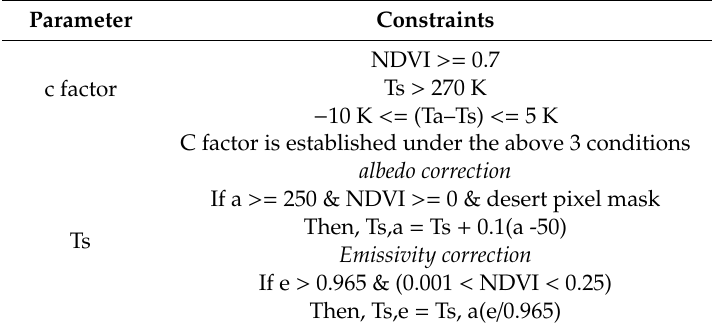
Table 2. SSEBop model parameter description and constraints. LST is the land surface temperature provided by the NASA LP DAAC archive, also denoted by Ts as a